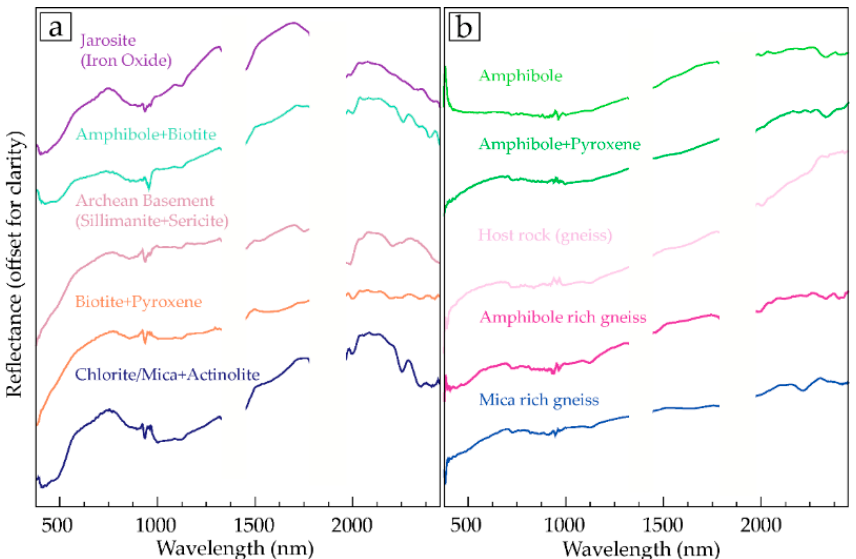
Figure 9. Spectral end-members from the: ( a ) Karrat region; and ( b ) Søndre Strømfjord region. Some differences between the end-member spectra are only visible at continuum-removed spectra (not shown here).